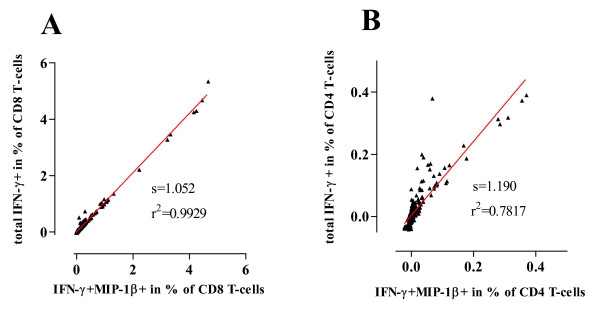
Linear regression analysis. Linear regression analysis between frequencies of IFN-γ+ MIP-1β+ T-cells and total IFN-γ+ T-cells is shown for CD8 (A) and CD4 (B) T-cells. The slope (s) and the goodness of fit (r2) are indicated in each graph. The regression line is depicted in each graph.